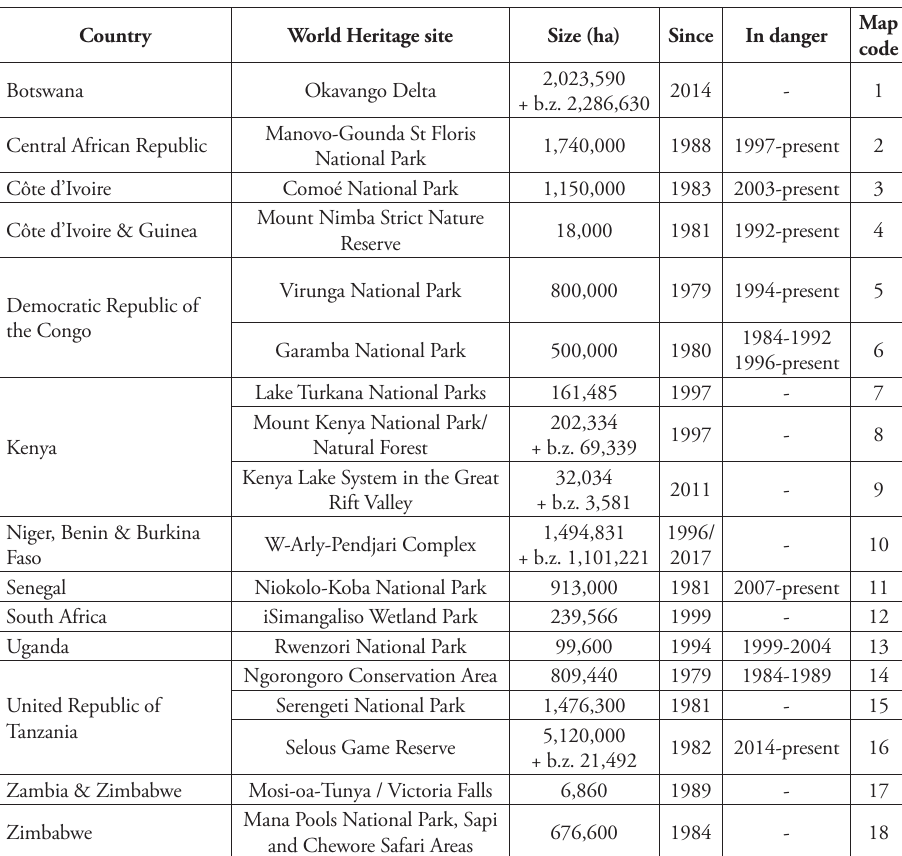
Table 4. Sites on the World Heritage List of importance to lion conservation. Whereas most of these sites currently have lions, some sites have been included from which lions have disappeared in the recent past. Map codes indicate the sites’ geographic locations as shown in Figure 1. For more detailed information on each site, including the reasons for listing and precise location and delimitation, see http://whc.unesco. org/en/list/. B.z. = buffer zone; In danger = listing on List of World Heritage in Danger. Country World Heritage site Size (ha) Since